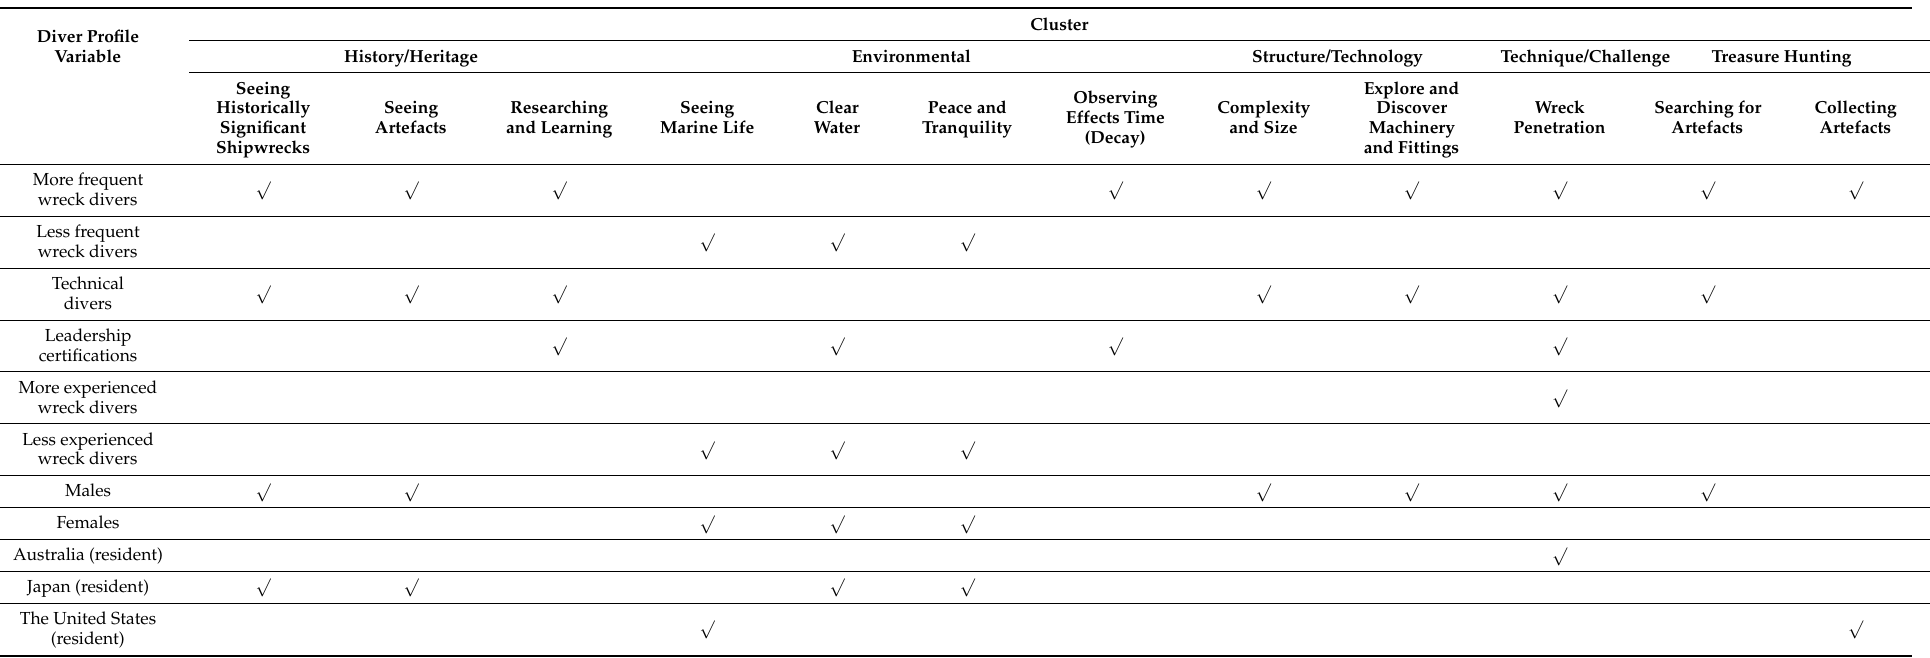
Table 1. Motivations to wreck dive: summary of key differences (from [37] (p.